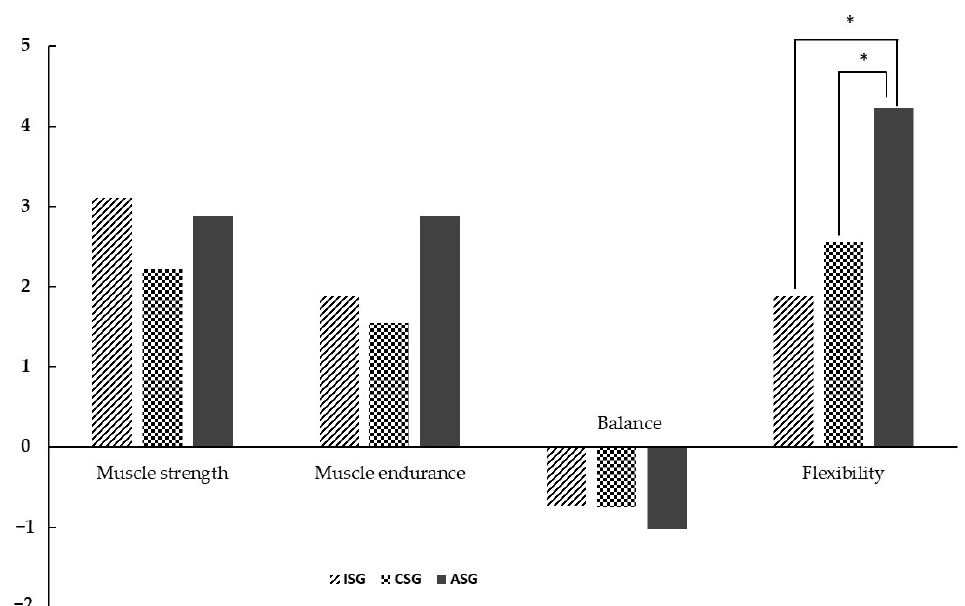
Figure 3. Comparison of the results between groups. ISG = infant stage group, CSG = childhood stage group, ASG = adult stage group. Muscle strength, muscle endurance (number of repetitions), balance (seconds), and flexibility (degrees), * p < 0.05.